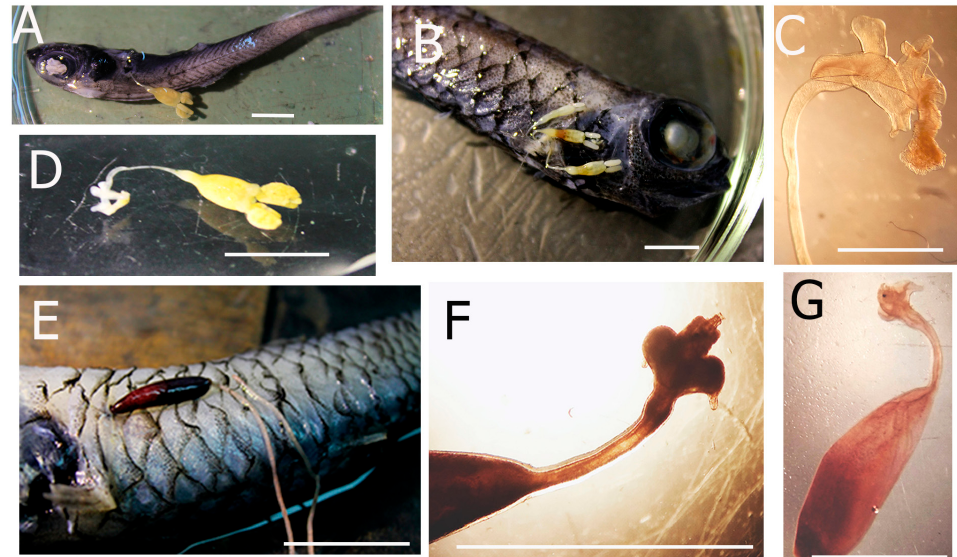
Figure 14. Paeonocanthus antarcticensis (Hewitt) ( A – D ) female and Sarcotretes sp. ( E – G ) female on Bathylagus antarcticus Günther. ( A , B )—Attached copepods on fish body, cephalothorax, and neck, embedded in the body muscles; ( C )—cephalothorax copepods after being soaked in lactophenol; ( D )—live copepod with egg sac, after extraction from the fish; ( E )—attached copepod with im- planted cephalothorax in fish heart; ( F )—live copepod cephalothorax after extraction from the fish; ( G )—whole copepod after being soaked in lactophenol. Scalebars: ( A , B , D , E )—1 cm, ( F , G )—0.5 cm, ( C )—0.2 cm.